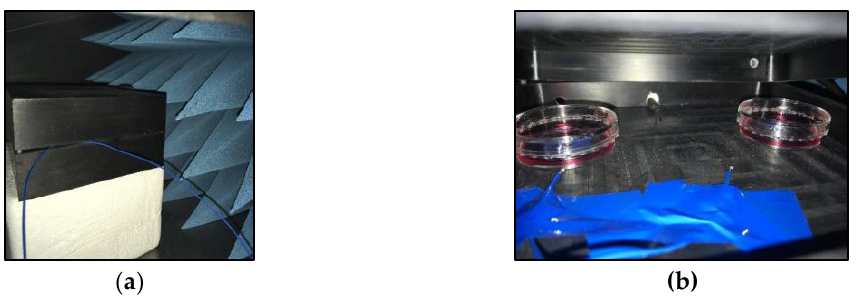
Figure 3. ( a ) The EUT chamber where the cells were placed; ( b ) NIH / 3T3 mouse fibroblast cell line cells